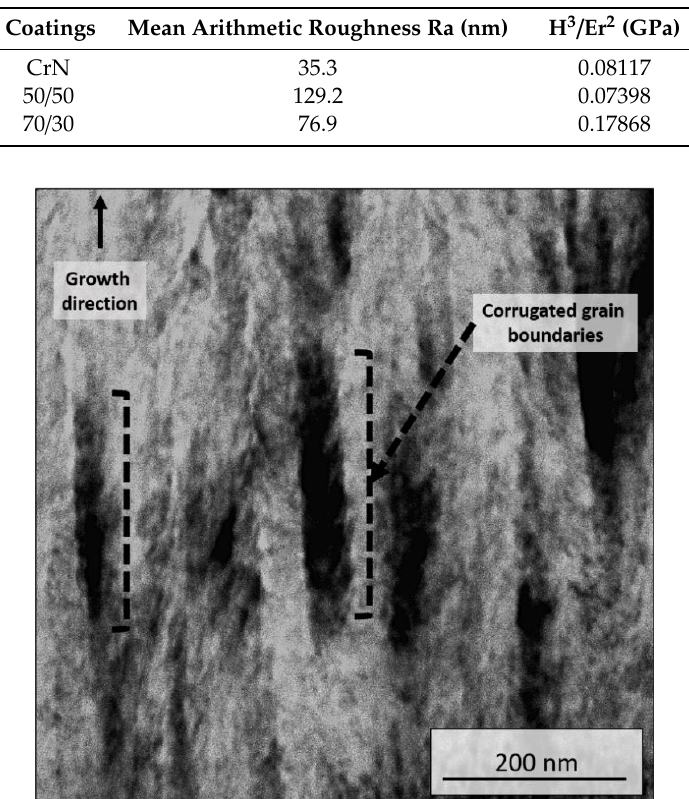
Figure 7. Bright field scanning transmission electron microscopy (STEM) image showing the corrugated nature of grain boundaries as a result of DGLAD growth in the 70/30 coating.